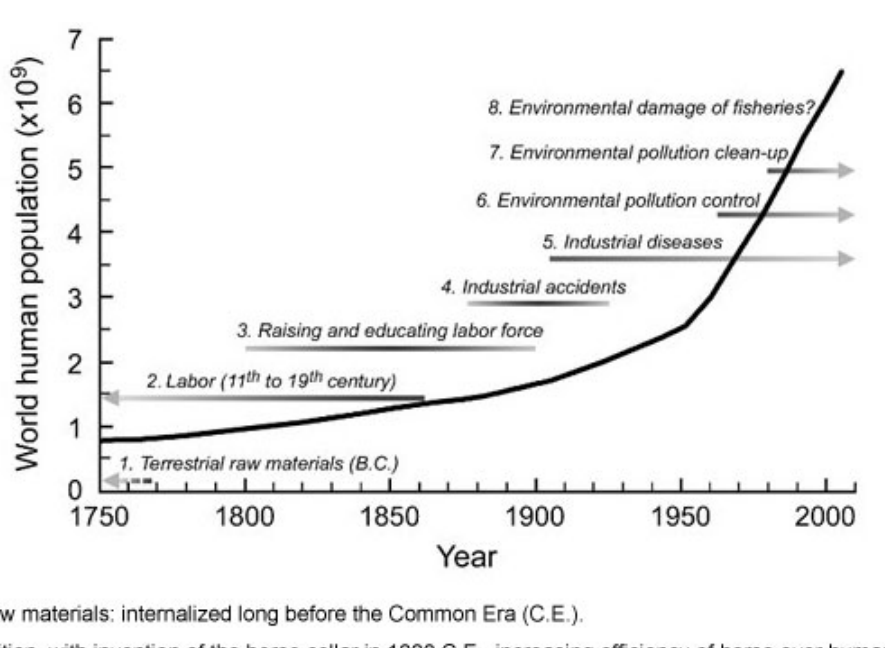
Fig. 1. Historical sequence of internalization of social and environmental “external costs” (adapted from Hardin 1972:81, with global human population